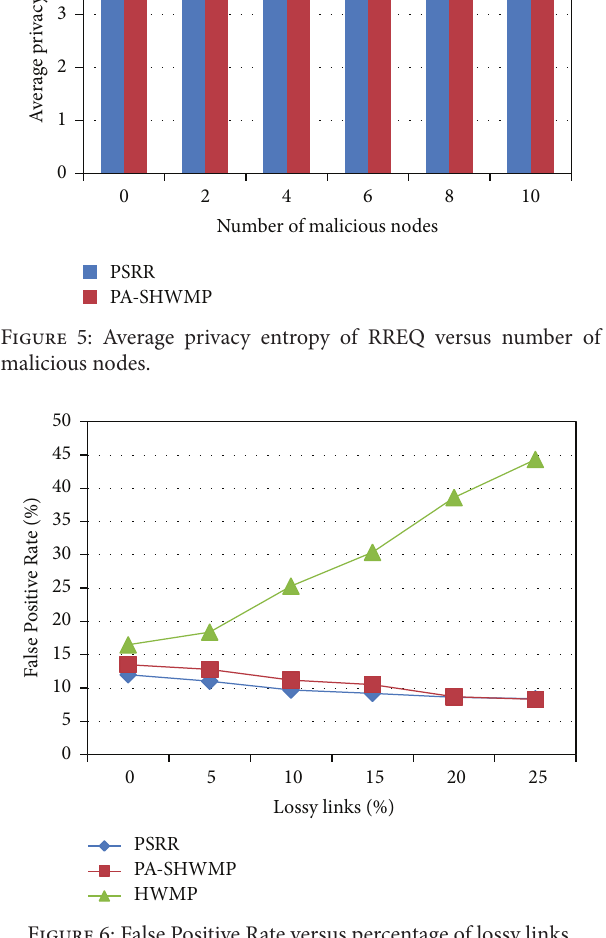
Figure 4: Average end-to-end delay versus number of malicious nodes.